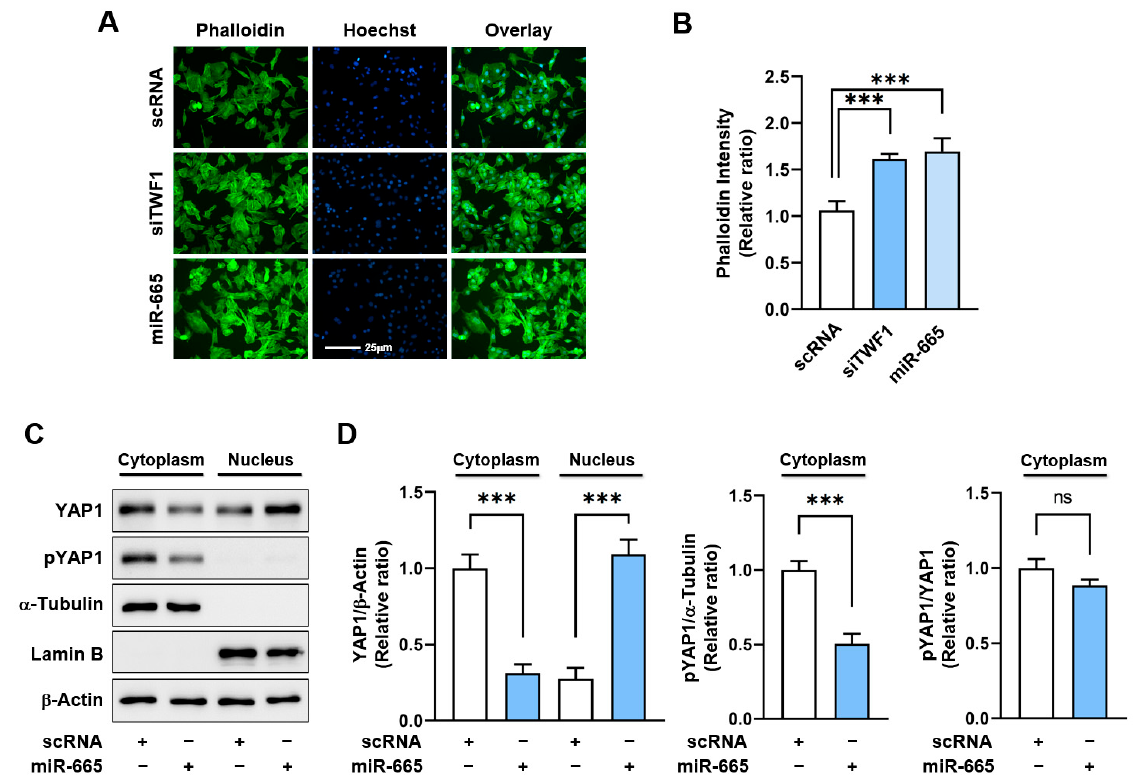
Figure 3. MiR-665-3p promoted F-actin accumulation and the nuclear localization of YAP1. C2C12 cells were transfected with 200 nM scRNA, siTWF1, or miR-665-3p mimic for 24 h. ( A , B ) FITC- Phalloidin staining was used to analyze F-actin formation (green). Nuclei were counterstained with Hoechst 33,342 (blue). Scale bar: 25 μ m. ( C ) Representative immunoblots of YAP1 and phosphor- YAP1 (pYAP1) in the nuclear and cytoplasmic fractions. The quality of subcellular fractionation was confirmed by Lamin B and α -Tubulin, which were used as nuclear and cytoplasmic markers, respectively. ( D ) Densitometry results of YAP1 and pYAP1 expression were normalized versus designated molecules, such as β -Actin, α -Tubulin and YAP1, respectively. Results are expressed as the means ± SEMs of intensity ratios versus scRNA controls ( n = 3; ***, p < 0.001 vs. scRNA). ns: no